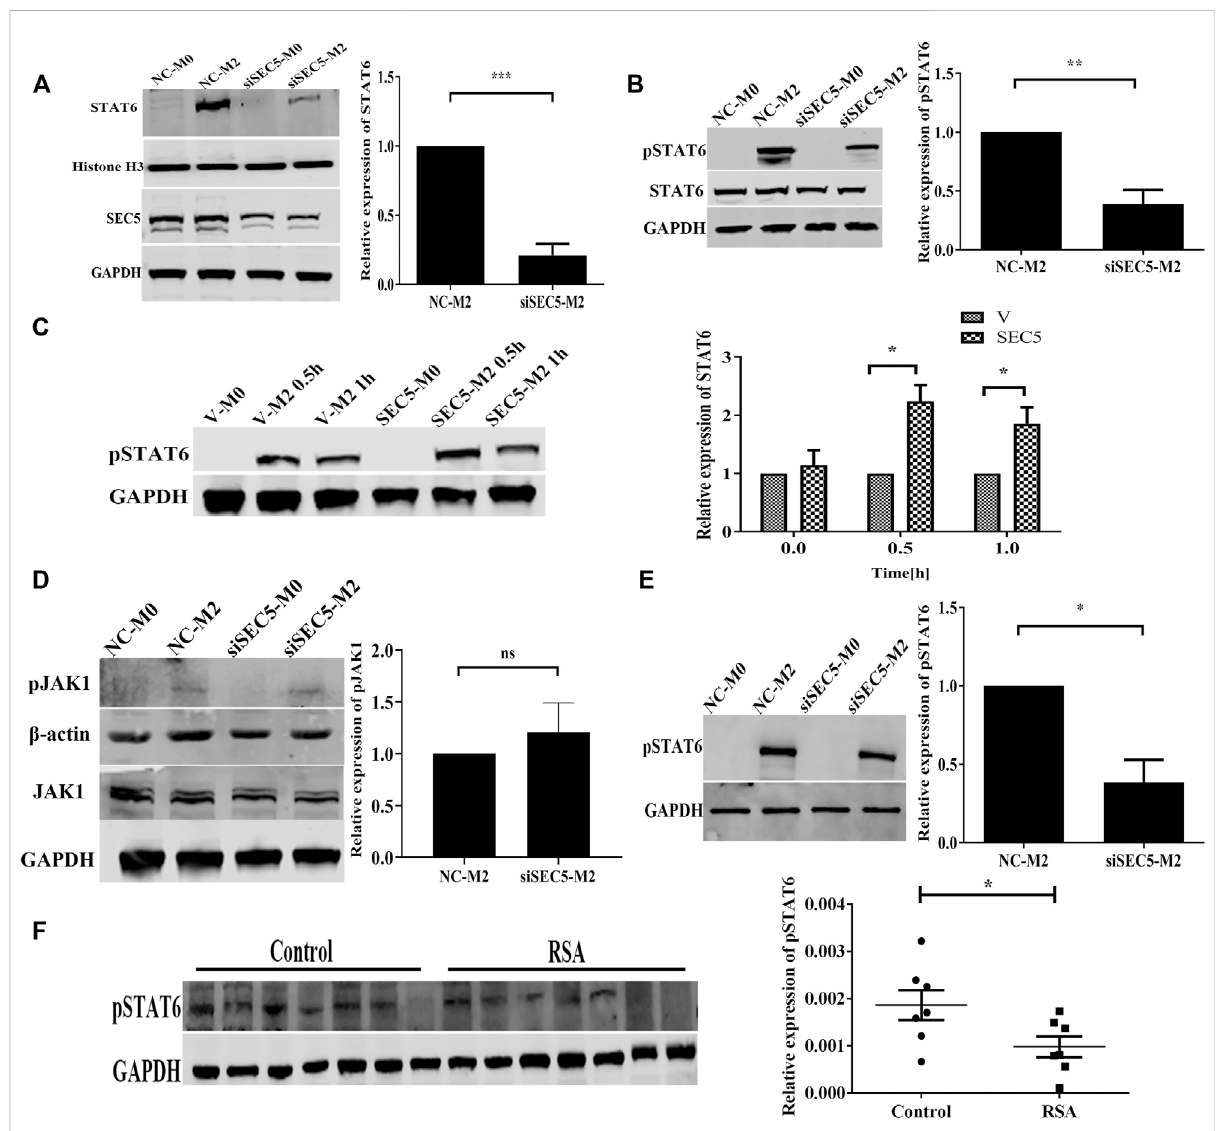
FIGURE 3 Phosphorylated STAT6 levels in SEC5 knockdown M ϕ s and dM ϕ s of patients with RSA. (A) Upper: expression level of STAT6 in the nuclei of THP1-derived M ϕ s examined by western blotting; lower: validation of downregulated SEC5 expression in THP1-derived M ϕ s transfected with SEC5- siRNA. NC-M0: M0-M ϕ s transfected with the negative control; NC-M2: M0-M ϕ s transfected with the negative control and stimulated with IL-4 and IL-13; siSEC5-M0: M0-M ϕ s transfected with SEC5-speci fi c siRNA; siSEC5-M2: M0-M ϕ s transfected with SEC5-speci fi c siRNA and stimulated withIL-4and IL-13. (B) Cytoplasmiclevels oftotalSTAT6 andphosphorylated STAT6 (pSTAT6)inTHP1-derivedM ϕ sdeterminedbywestern blotting. NC-M0/NC-M2/siSEC5-M0/siSEC5-M2: same as in (A) (C) Expression level of phosphorylated STAT6 (pSTAT6) in SEC5-overexpressing THP1- derived M ϕ s detected bywestern blotting.v-M0: M0-M ϕ s transfected with vector plasmid; v-M20.5 h/1 h: M0-M ϕ stransfectedwith vector plasmid and stimulated with IL-4 + IL-13 for 0.5 or 1 h; SEC5-M0: M0-M ϕ s transfected with pCDNA3.0-GFP-Flag-SEC5 plasmid; SEC5-M2 0.5 h/1 h: M0- M ϕ stransfectedwithpCDNA3.0-GFP-Flag-SEC5plasmidandstimulatedwithIL-4+IL-13for0.5or1 h. (D) Expression levelofphosphorylated JAK1 (pJAK1) in THP1-derived M ϕ s determined by western blotting. NC-M0/NC-M2/siSEC5-M0/siSEC5-M2: same as in (A) (E) Expression level of phosphorylated STAT6 (pSTAT6) in mouse BMDMs determined by western blotting. NC-M0: BMDMs transfected with the negative control; NC-M2: BMDMs transfected with the negative control and stimulated with IL-4 + IL-13; siSEC5-M0: BMDMs transfected with SEC5-speci fi c siRNA; siSEC5- M2:BMDMstransfectedwithSEC5-speci fi csiRNAandstimulatedwithIL-4-+-IL-13. (F) ExpressionlevelofphosphorylatedSTAT6(pSTAT6)indM ϕ s of patients with RSA detected by western blotting. Control: dM ϕ s of healthy pregnant women; RSA: dM ϕ s of patients with RSA. All experiments